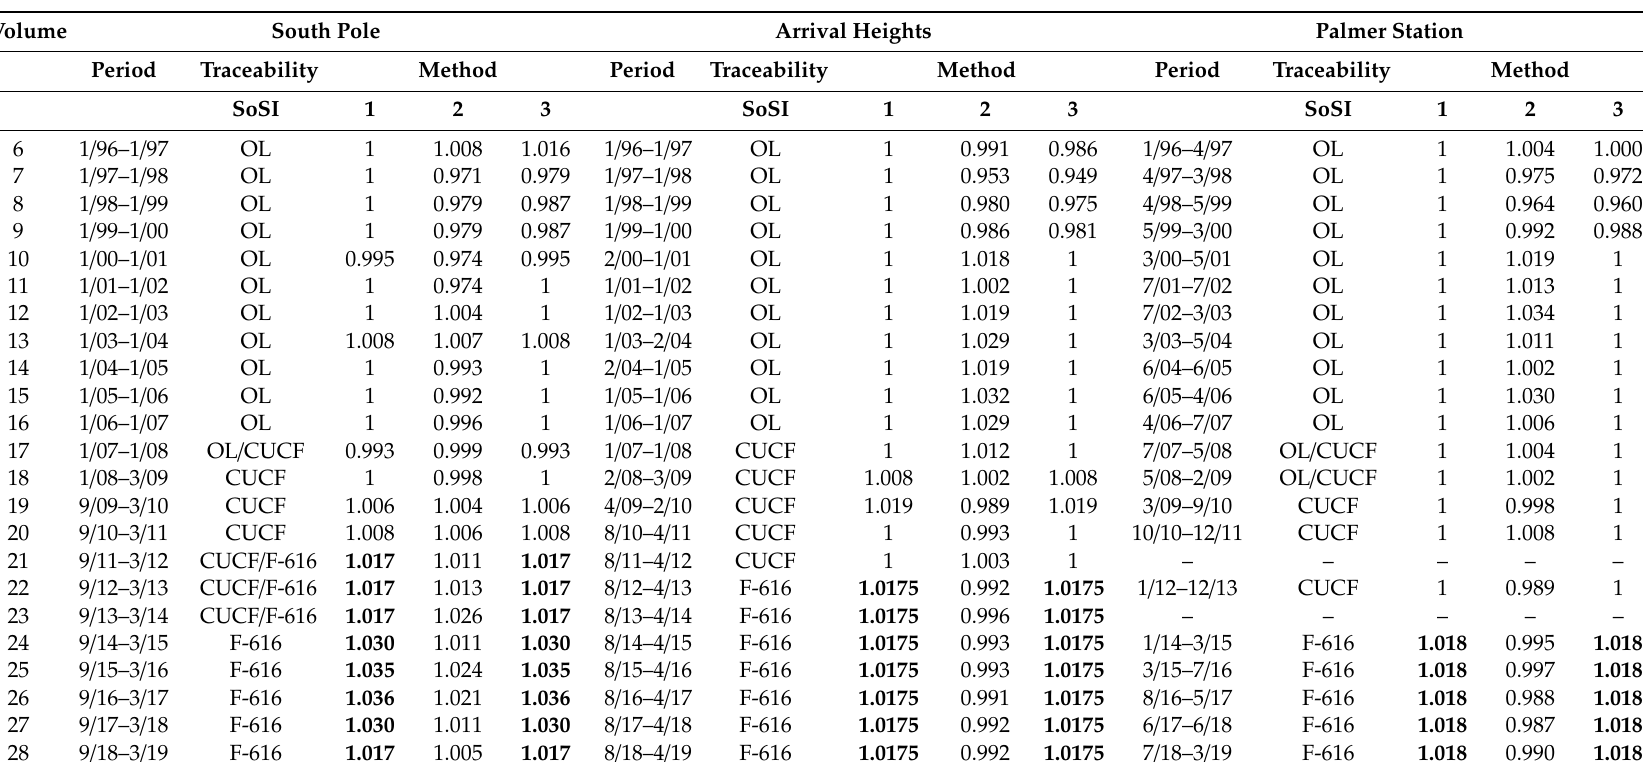
Table 1. Assignment of data volumes (Volume) to observation periods (Period, indicated by month / year start and end); traceability of the scales of spectral irradiance (SoSI); and correction factors derived either with Method 1 (review of SoSI (Sections 2.4 and 2.5)); Method 2 (comparison with model spectra (Section 2.6)); or with a combination of both methods (Method 3, Section 2.7) for the South Pole, Arrival Heights, and Palmer Station. Values printed in bold face are a ff ected by the change in the SoSI from the Central UV Calibration Facility (CUCF) standards to lamp